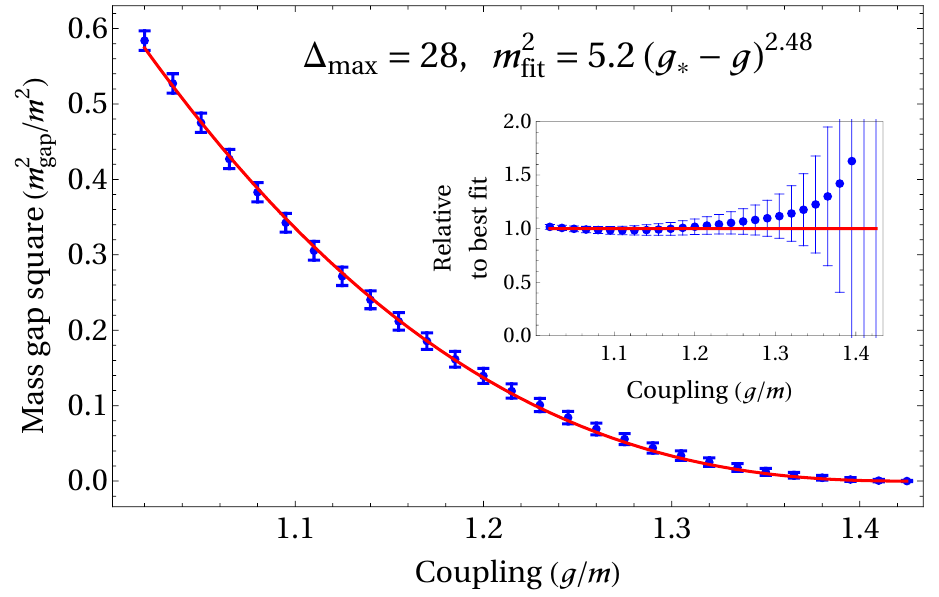
Figure 5 . The power law fit to m 2 as a function of g near the critical coupling g on the massive ∗ gap side. The blue dots are the ( g , m 2 ) data points obtained from diagonalizing the Hamiltonian i gap ,i Q 2 at coupling g . The magnitude of the error bar on the points are defined as the change of m gap i + magnitude between ∆ max = 26 and ∆ max = 28 fixing g . The red curve is the best fit. The inset i plot shows the same data and fit, normalizing the best fit m 2 to fit